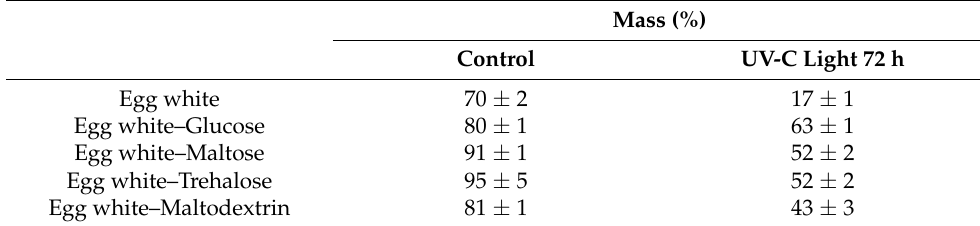
Table 2. Mass percentage ( ± standard deviation) flowing downstream upon filtration of freeze-dried egg white, sugars and egg white–sugar mixtures before and after exposure to UV-C light for 72 h (UV-C